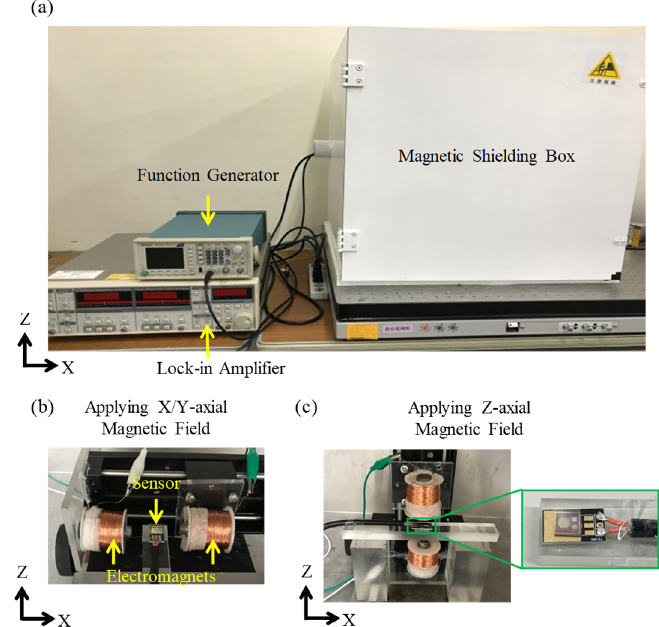
Figure 8. The photographs of the testing setup: ( a ) testing setup for three-axial AC magnetic field sensing. Enlarged photographs of the testing setup for applying ( b ) X/Y-axial and ( c ) Z-axial magnetic fields to the sensor. Note: (b) and (c) are setups inside the magnetic shielding box in (a).